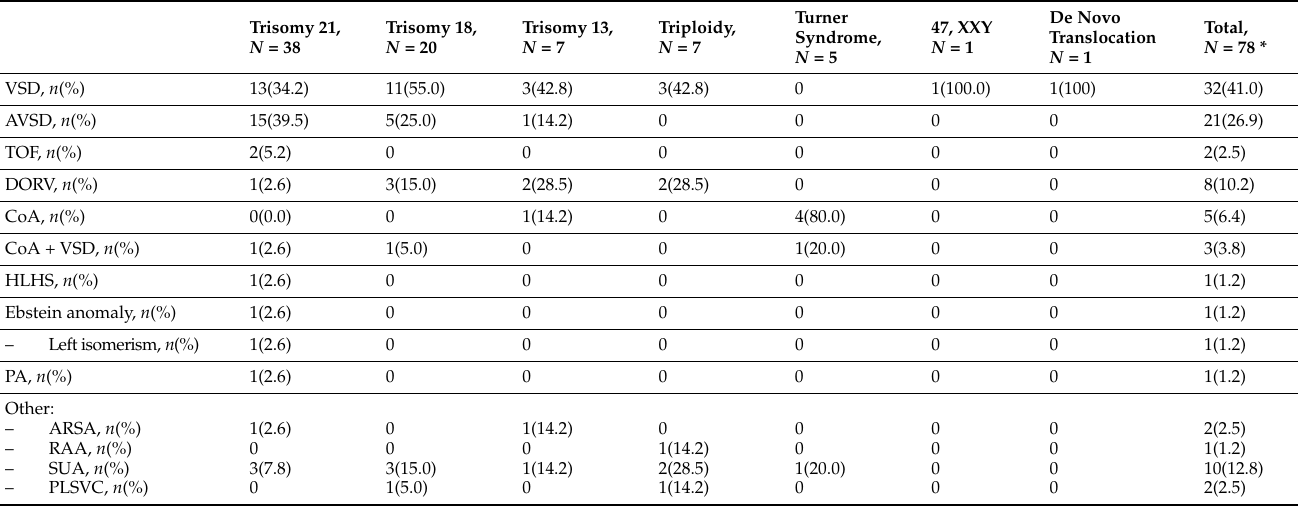
Table 4. Cardiovascular anomalies and numerical chromosomal aberrations in 1005 pregnant women undergoing invasive prenatal